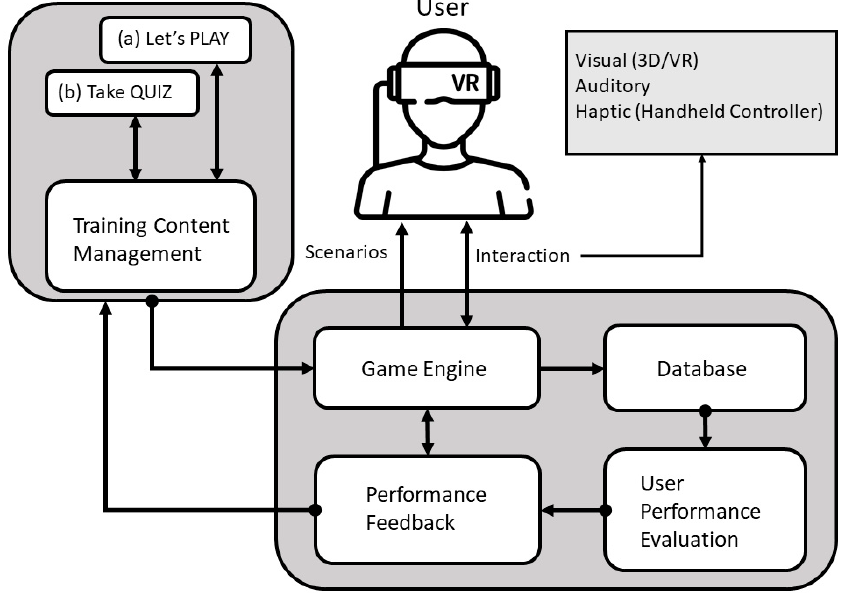
Figure 6. Diagram presenting the structure of components and operations of MedChemVR.